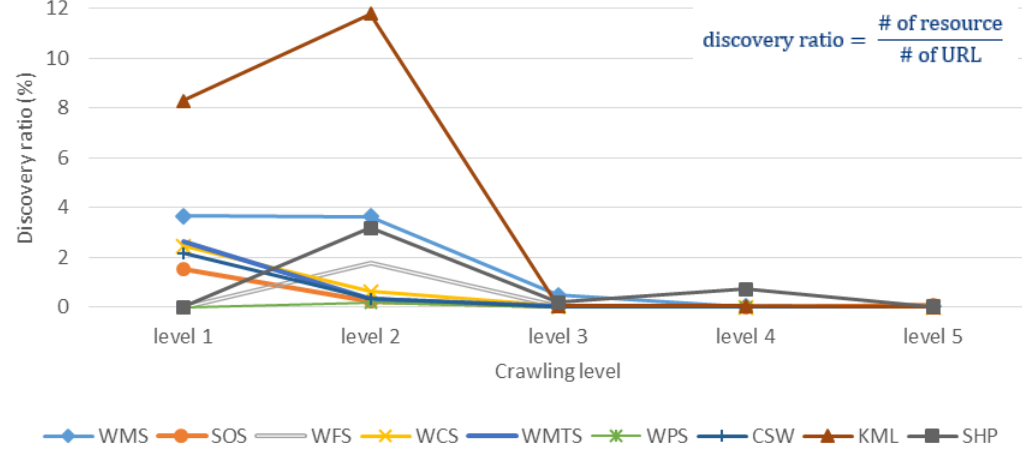
Figure 11. The resources discovery ratio in different crawling levels.